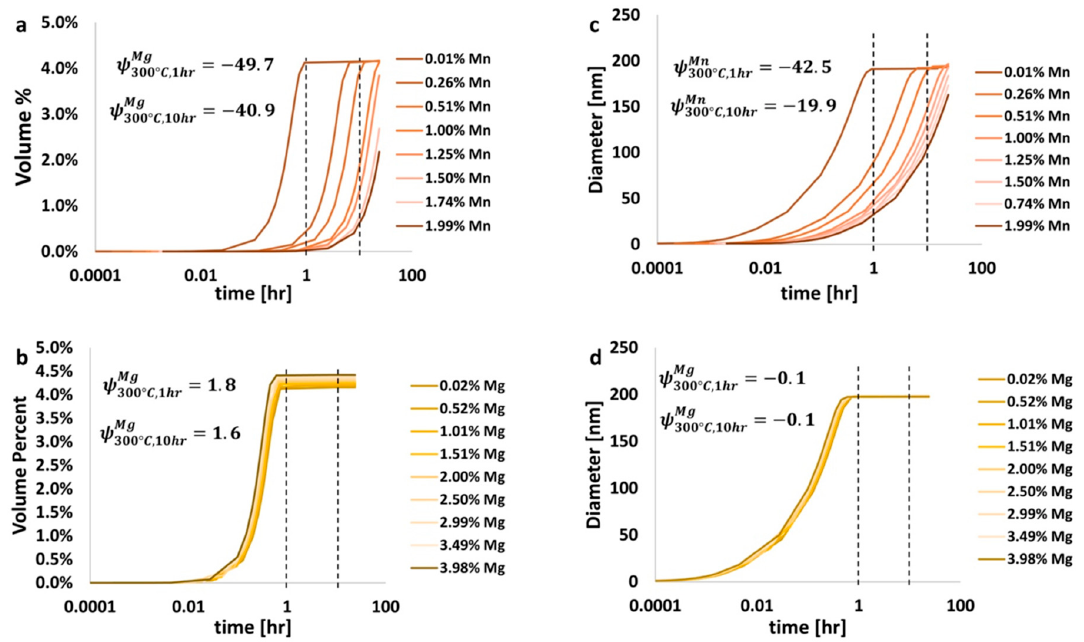
Figure 11. 𝜓 calculations of temporal precipitation properties. At 300 °C, the volume fraction, represented in ( a , b ), and precipitate diameter, represented in ( c , d ) are calculated for theta in Al-Cu-